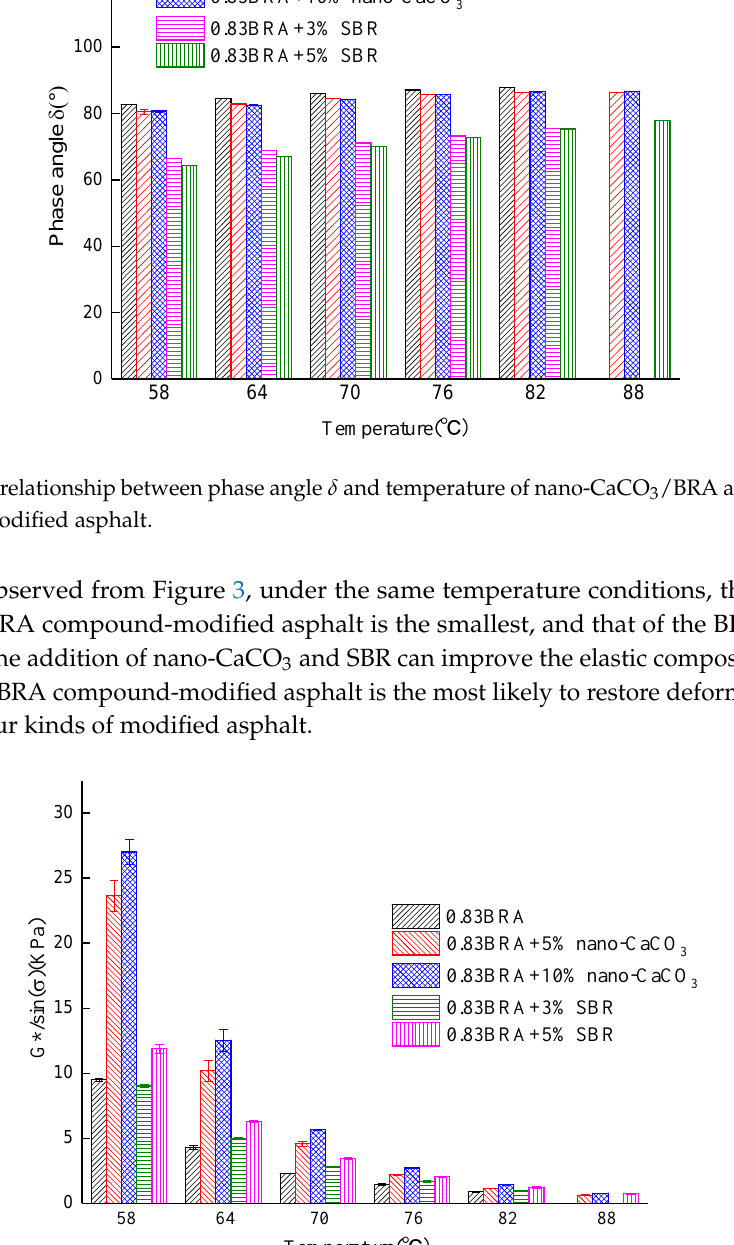
Figure 4. The relationship between anti-rutting factors G* /sin δ and the temperature of nano- CaCO 3 /BRA and SBR/BRA compound-modified asphalt.